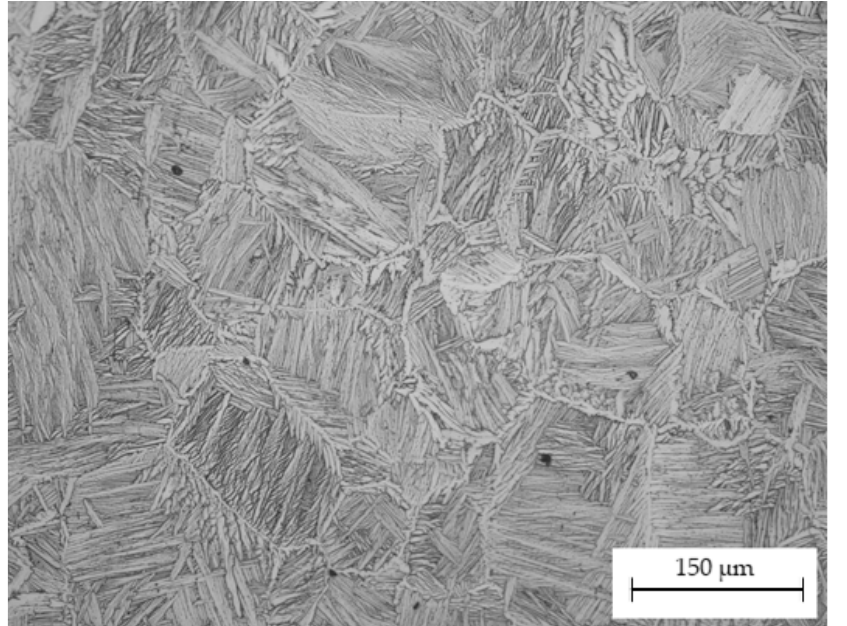
Figure 3. Optical micrograph showing a typical lamellar/Widmanstätten type structure of Ti-6Al-4V alloy attained after air cooling from β phase field.